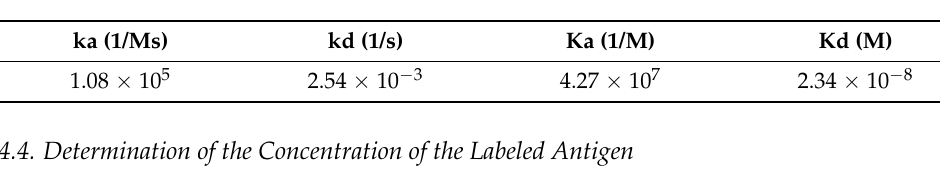
Table 2. Kinetic and equilibrium constants of the interaction of the Rv0934 antigen with monoclonal antibodies